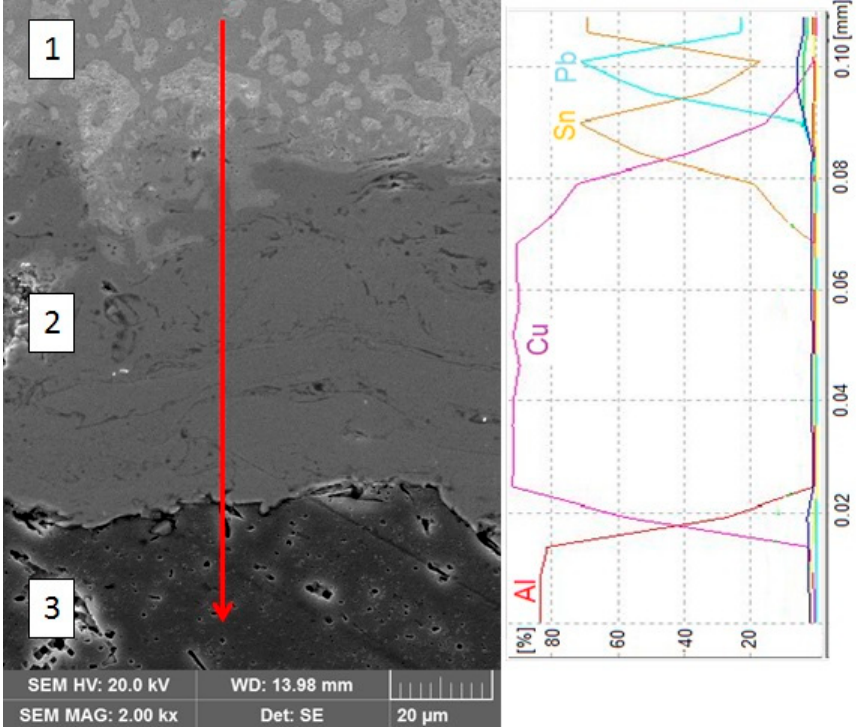
Figure 10. Micrograph of the interface between solder and Cu intermediate layer close to 6060 aluminum alloy together with linear EDS analysis: 1—solder; 2—Cu coating; 3—6060 aluminum alloy.